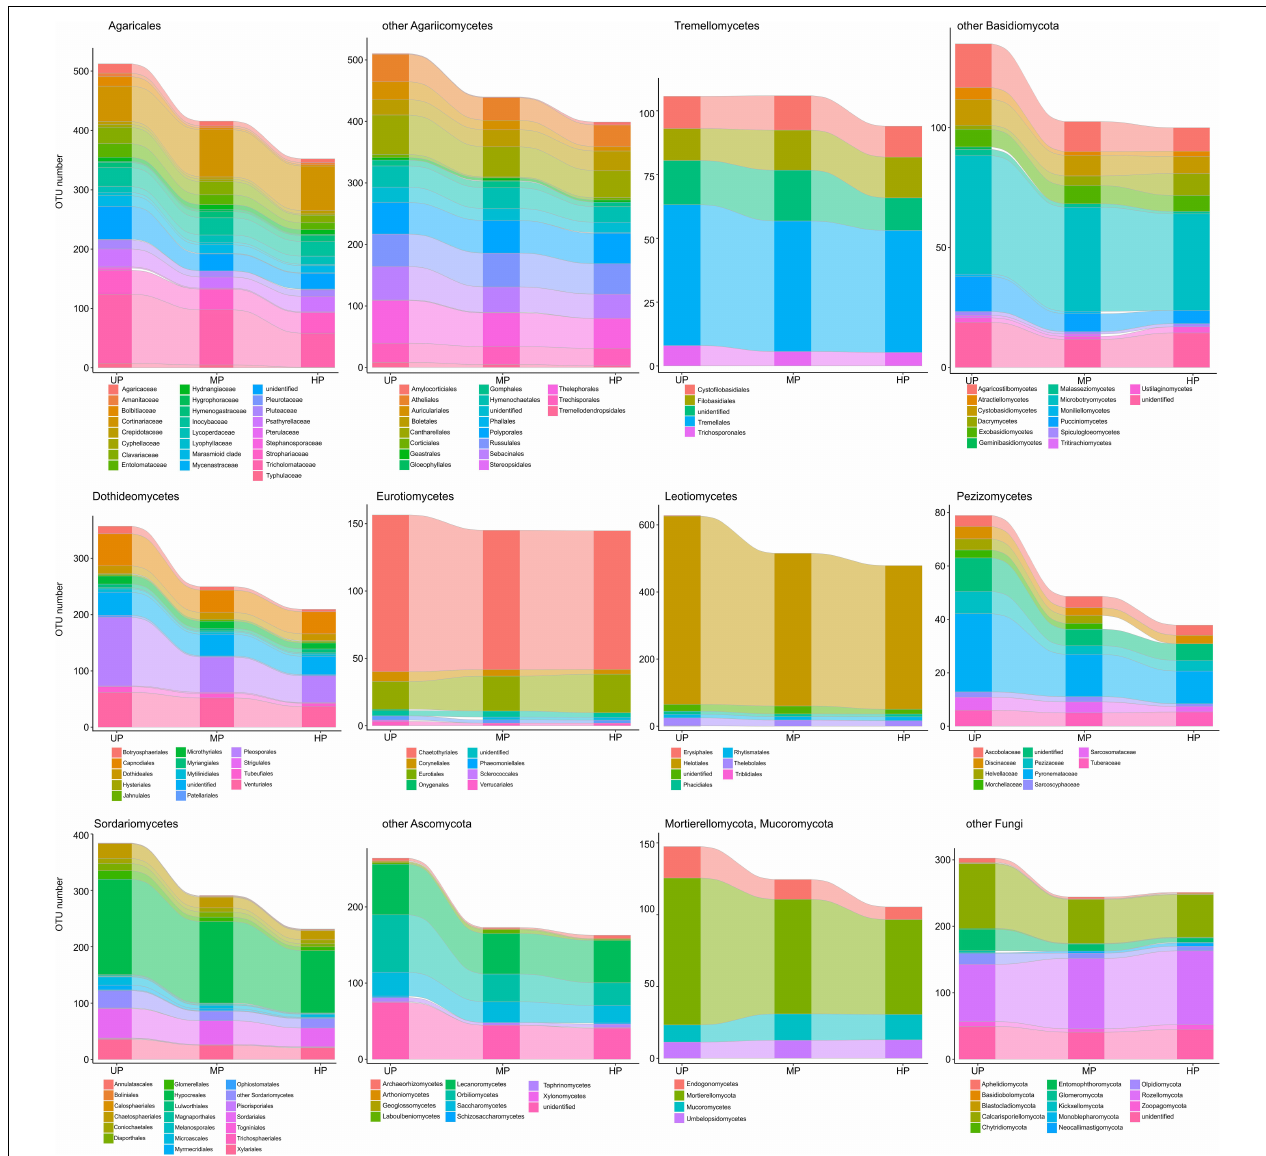
FIGURE 9 | Total OTU number of fungal taxa in the litter collected close to CWD in unpolluted (UP), moderately polluted (MP), and heavily polluted (HP) areas ( n = 29 samples per area). OTU, operational taxonomic unit; CWD, coarse woody debris.